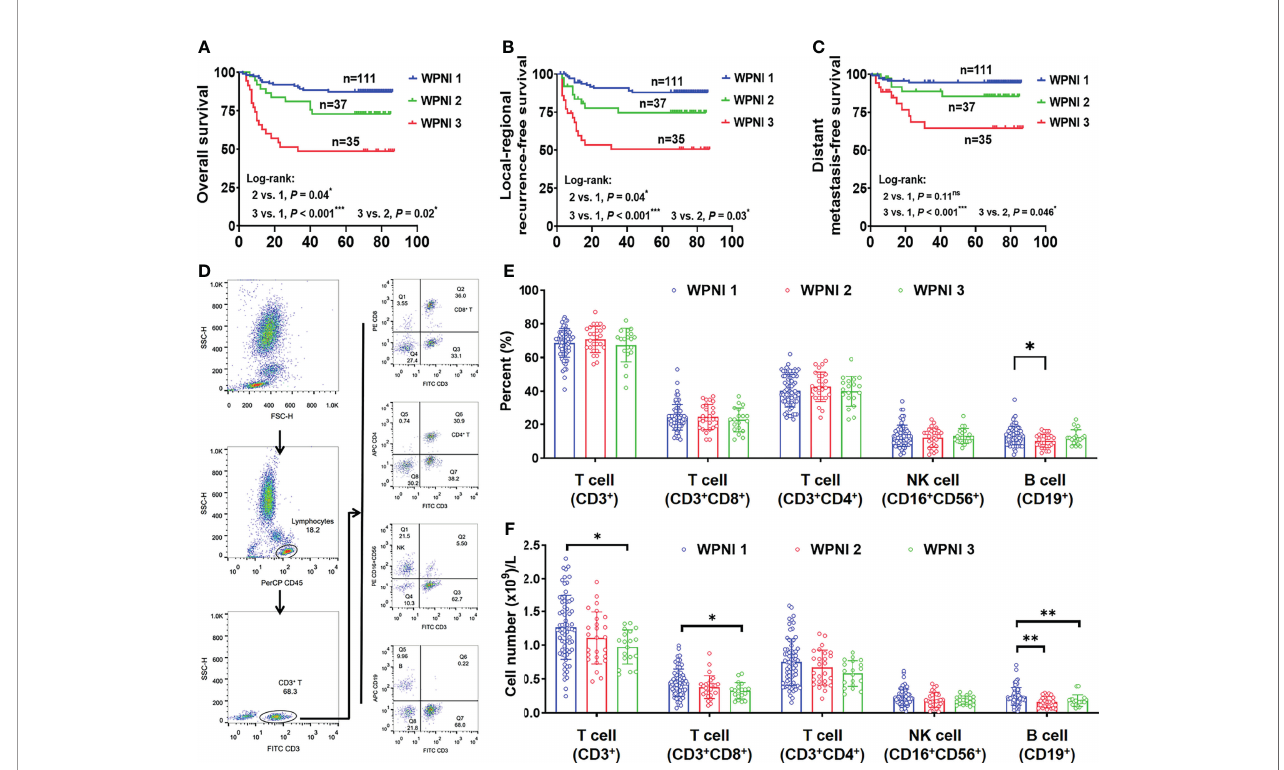
FIGURE 5 | WPNI 3 OSCC patients showed the worst prognosis and immune response. (A – C) Kaplan-Meier analysis for overall survival (A) , local-regional recurrence-free survival (B) , and distant metastasis-free survival (C) in patients strati fi ed by the WPNI scoring system. (D) The gating strategy for fl ow cytometry analysis. (E, F) Comparison of the circulating lymphocytes among OSCC patients with different WPNI scores.